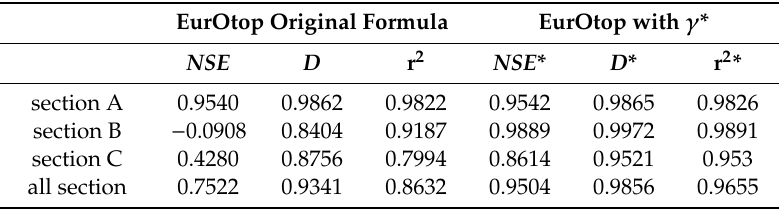
Table 6. Test results for cross-section type